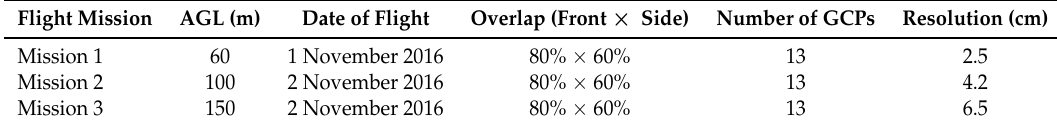
Table 2. Summary of the sUAS flight parameters for the study site.